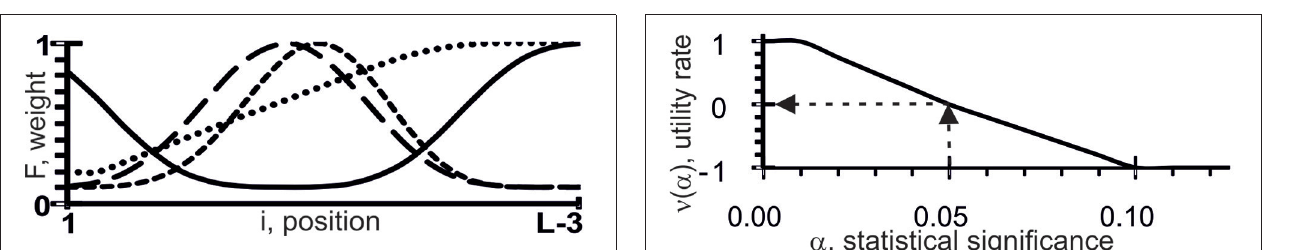
variants of weighted tetranucleotide abundance ([z 1 z 2 z 3 z 4 ] F ), their number being 360 × 15 4 = 18225000 ≈ 10 7 .